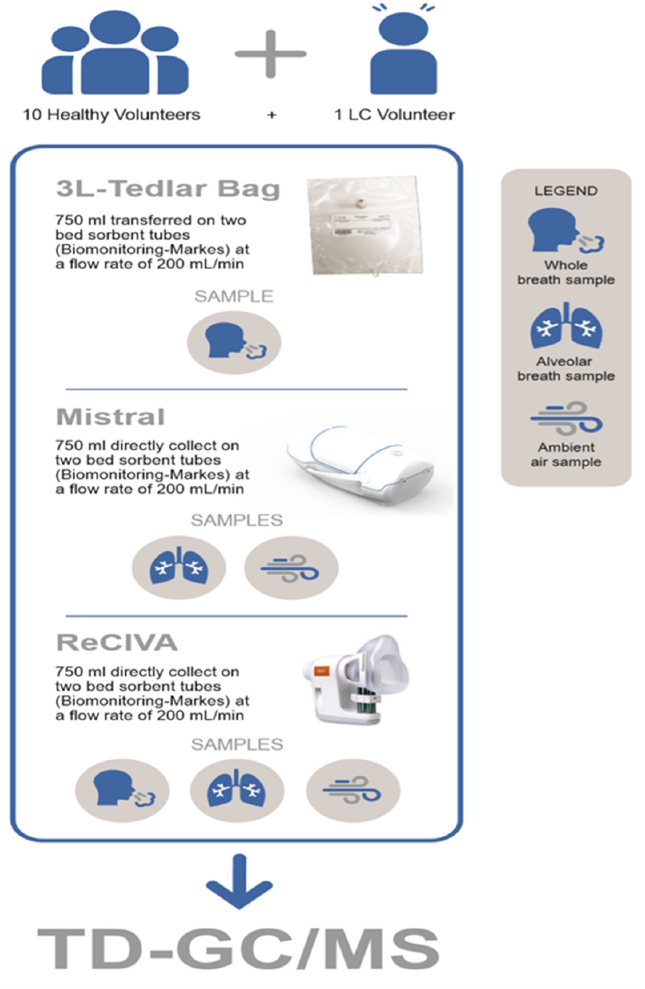
Figure 1. Schematic diagram of the experimental section.